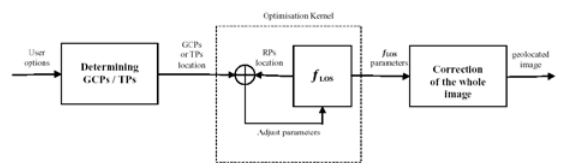
Figure 1: Georeferencing concept by inversion of the LOS